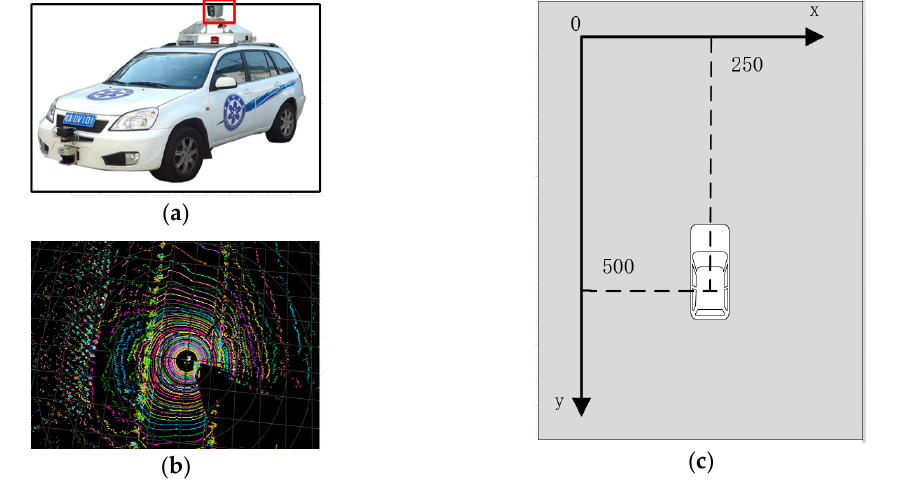
Figure 2. System introduction. ( a ) Intelligent Pioneer; ( b ) Raw point cloud; ( c ) Local